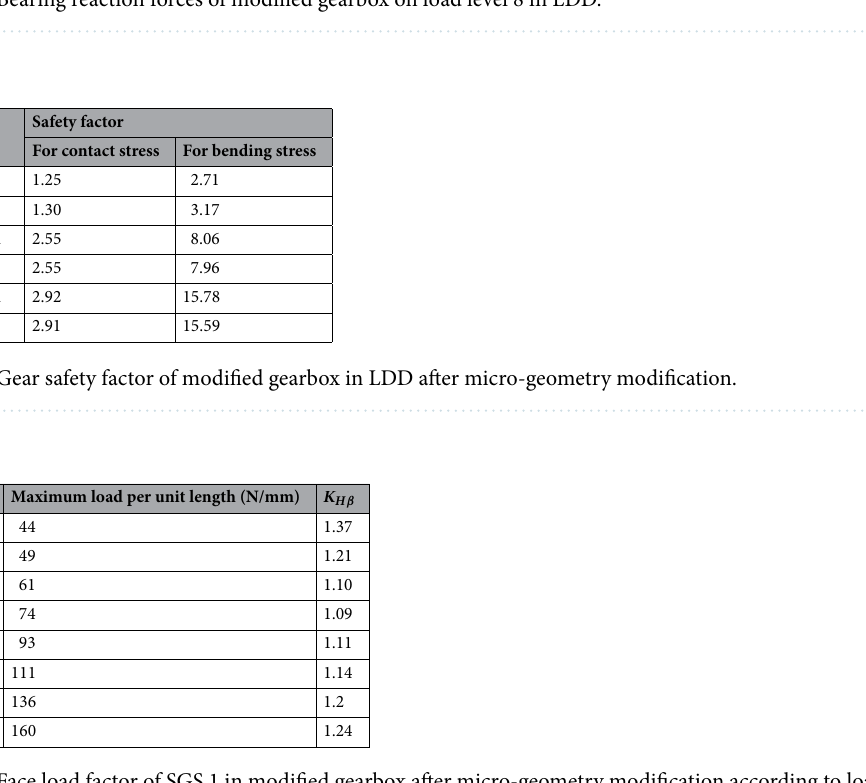
Table 11. Bearing reaction forces of modified gearbox on load level 8 in LDD.